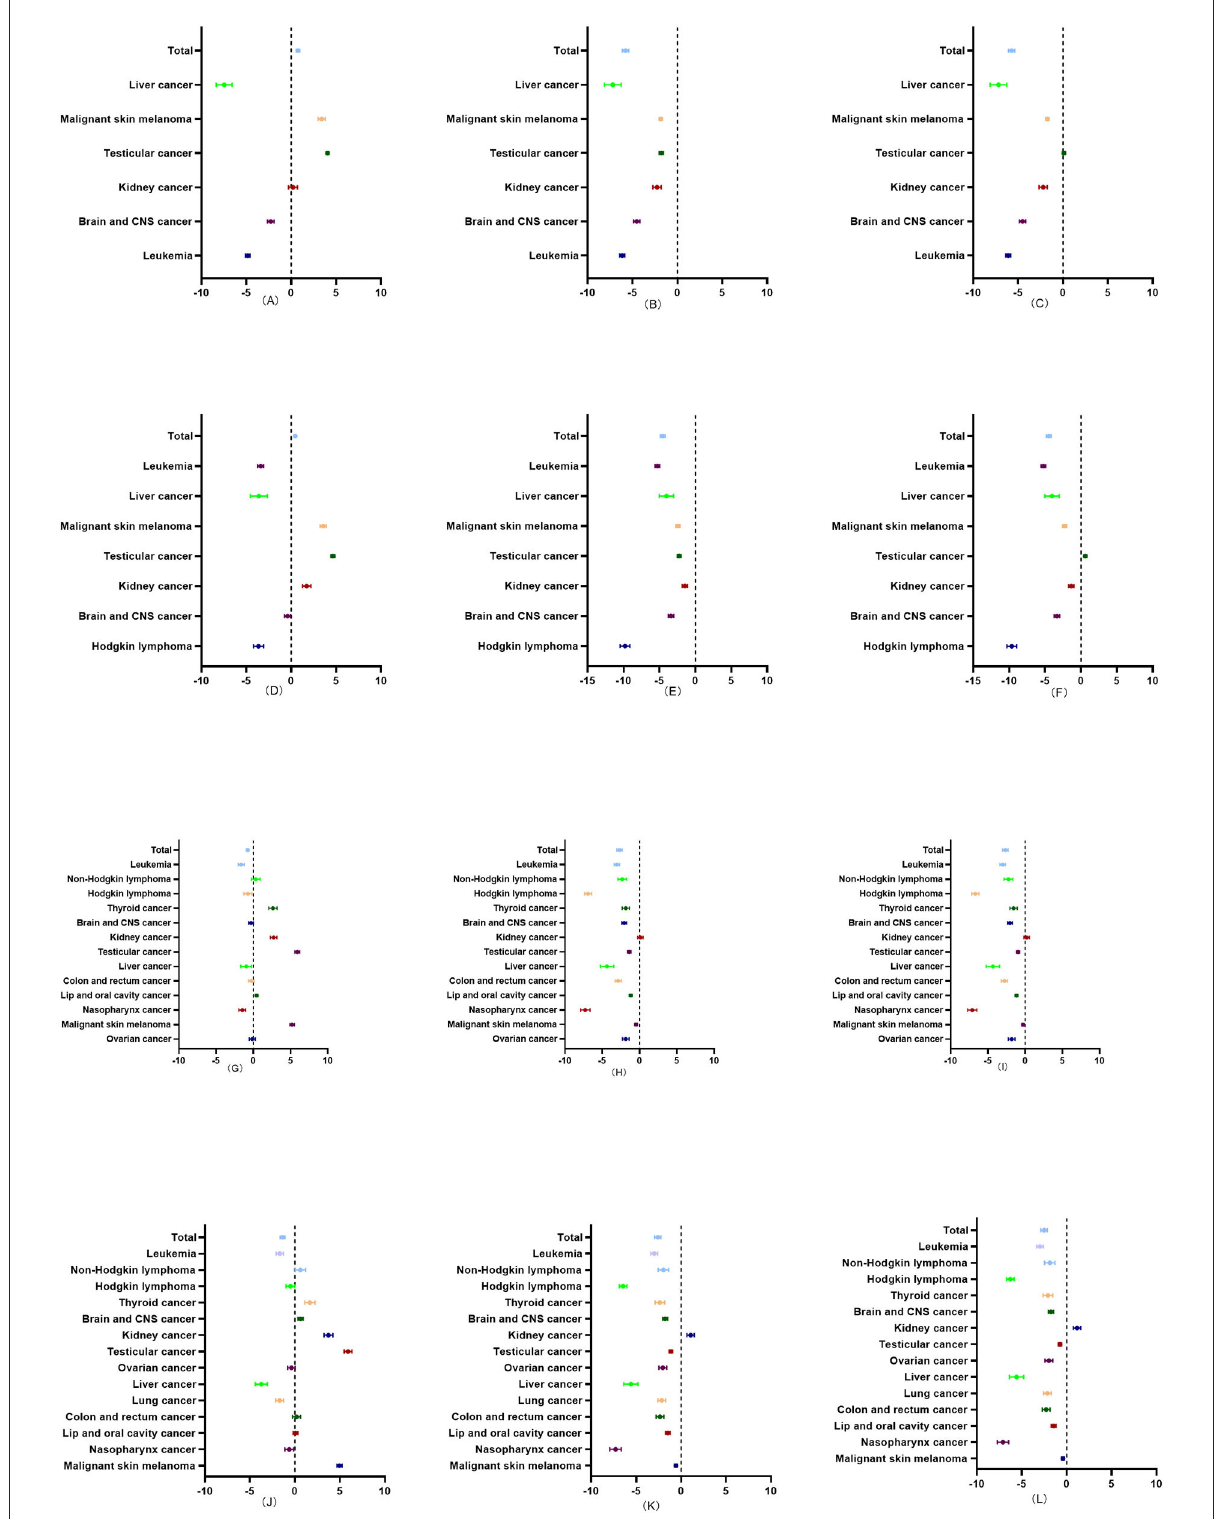
FIGURE4 Average annual percentage change (AAPC) in the incidence, mortality, and DALY rates of childhood cancers in four age groups ( < 1 year, 1–4, 5–9, and 10–14) in China from 1990 to 2019. (A) The AAPC in the incidence rate of childhood cancers in < 1 year age group in China from 1990 to 2019. (B) The AAPC in the mortality rate of childhood cancers in < 1 year age group in China from 1990 to 2019. (C) The AAPC in the DALY